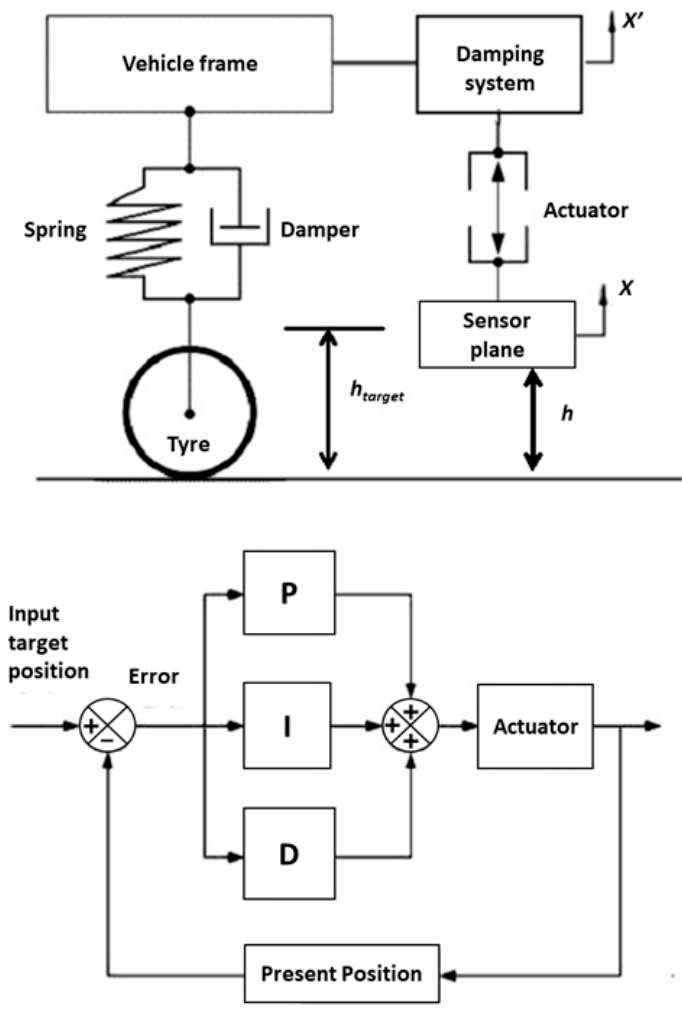
Figure 4. Damping system model and Proportional Integral Derivative (PID) controller of the height of the absorption measurement system. The Proportional Integral Derivative (PID) controller acts on the error e equal to the difference of